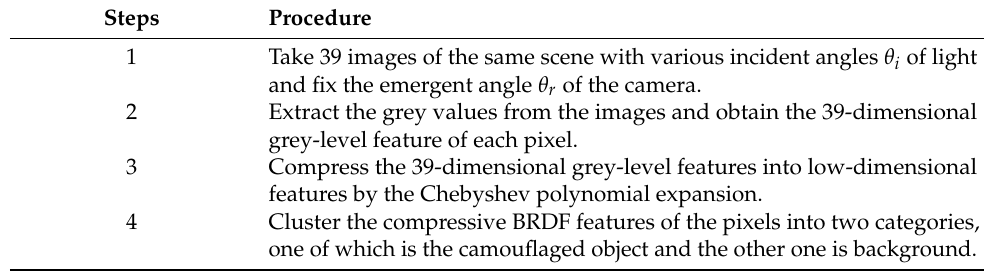
Table 1. Steps of the proposed camouflaged object segmentation